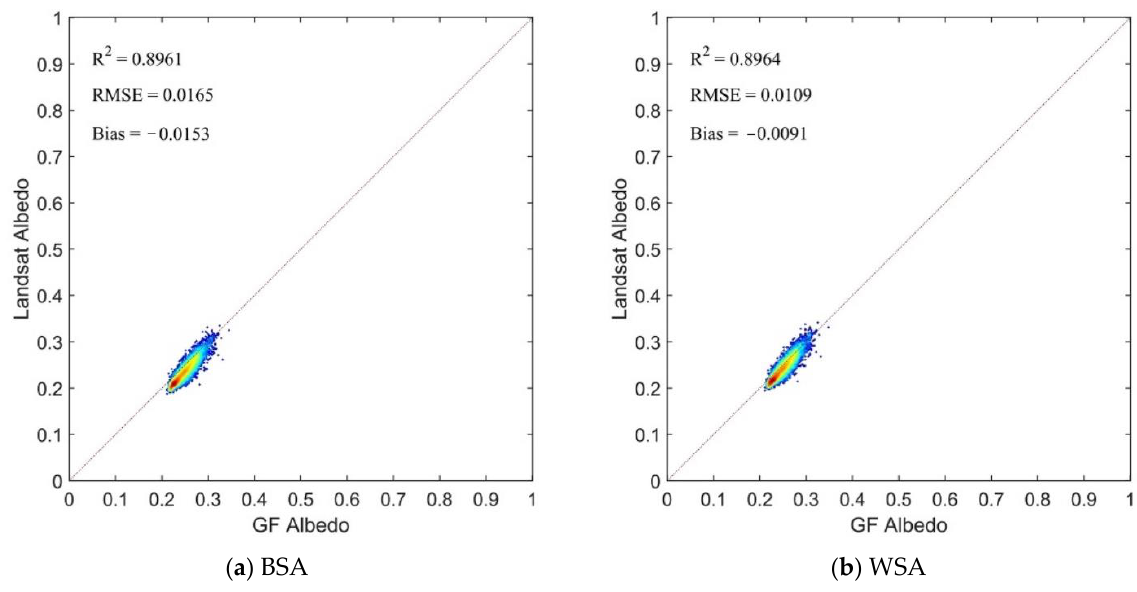
Figure 6. Comparison of ( a ) black-sky albedo and ( b ) white-sky albedo of GF-1 WFV ( left ) and Landsat-8 ( right ) in Ganzhou.